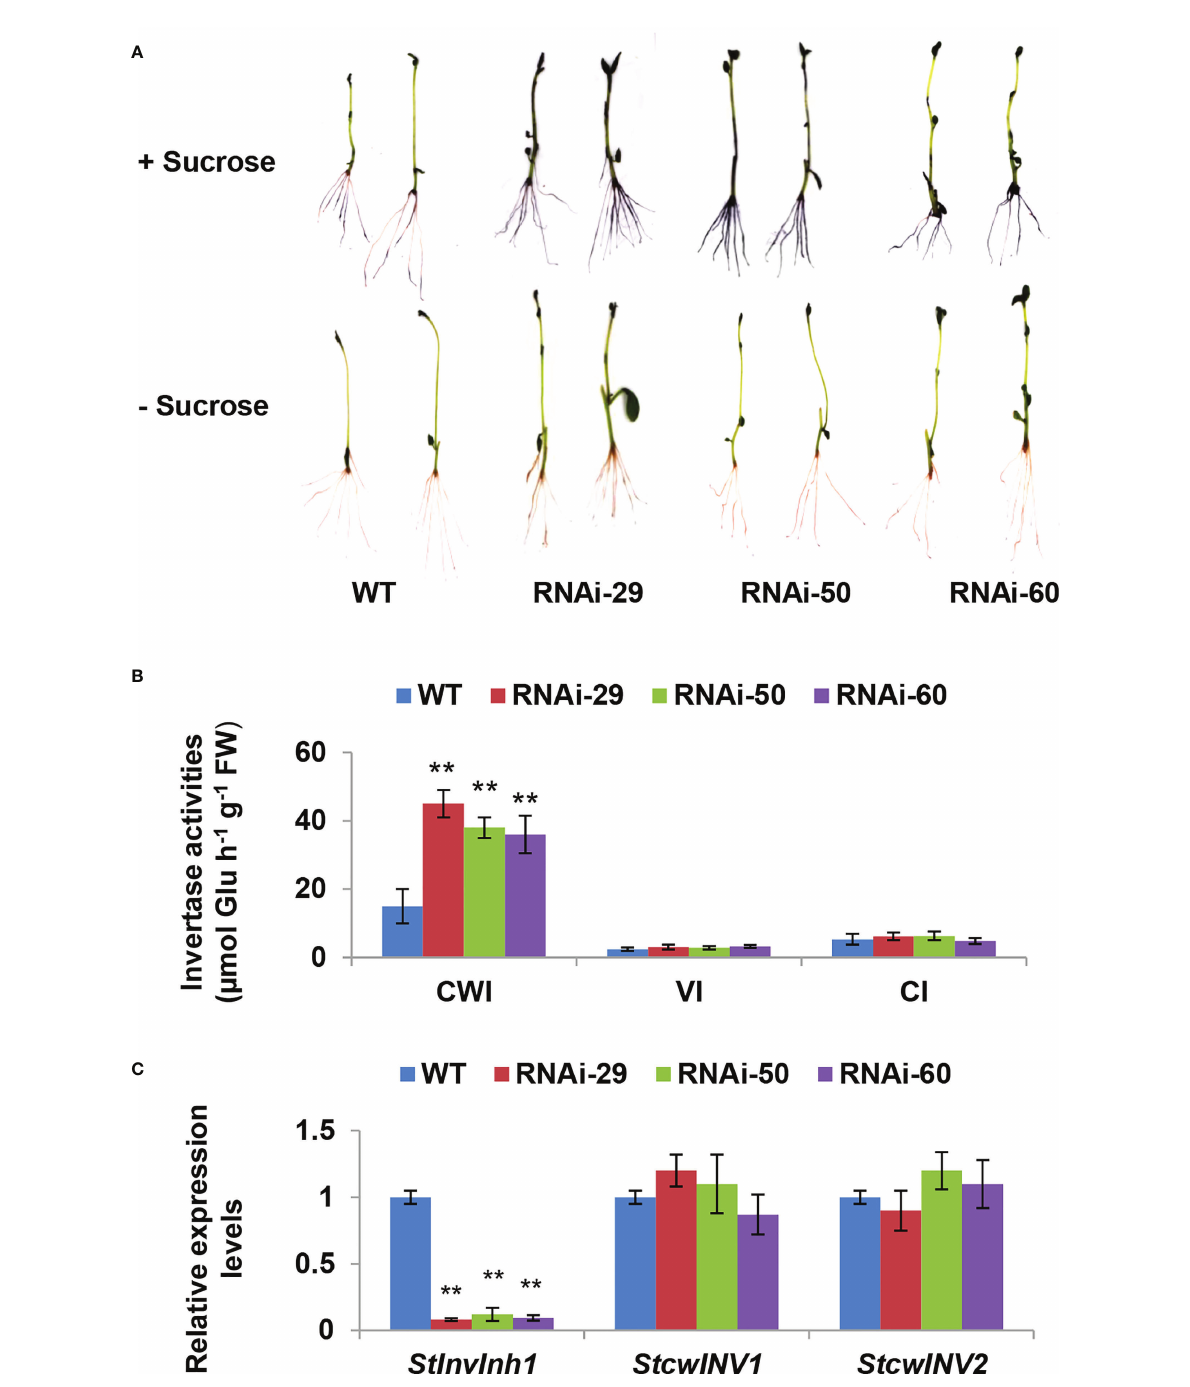
FIGURE 5 Silencing StInvInh1 expression speci fi cally releases CWI activity in transgenic plantlets. (A) Histochemical staining of NBT indicating the increased acid invertase activities in the RNAi plantlets. (B) The invertase activity determined by enzyme assay in vitro indicating the signi fi cantly increased the CWI activity in the RNAi plantlets without impacting the activities of VI and NI. (C) RT-qPCR analysis revealed that StInvInh1 was suppressed in the RNAi plantlets without impact on mRNA levels of the two CWI genes, StcwINV1 and StcwINV2 . The relative expression levels of StInvInh1 , StcwINV1 and StcwINV2 are presented in relation to the expression level of ef1 a (AB061263) transcripts (100). The relative expression level of each gene and each enzyme activity in transgenic lines was compared with that in wild-type control E3. Each value was the mean ± SD of three biological replicates. **Signi fi cant differences in values (P < 0.01) by Student ’ s